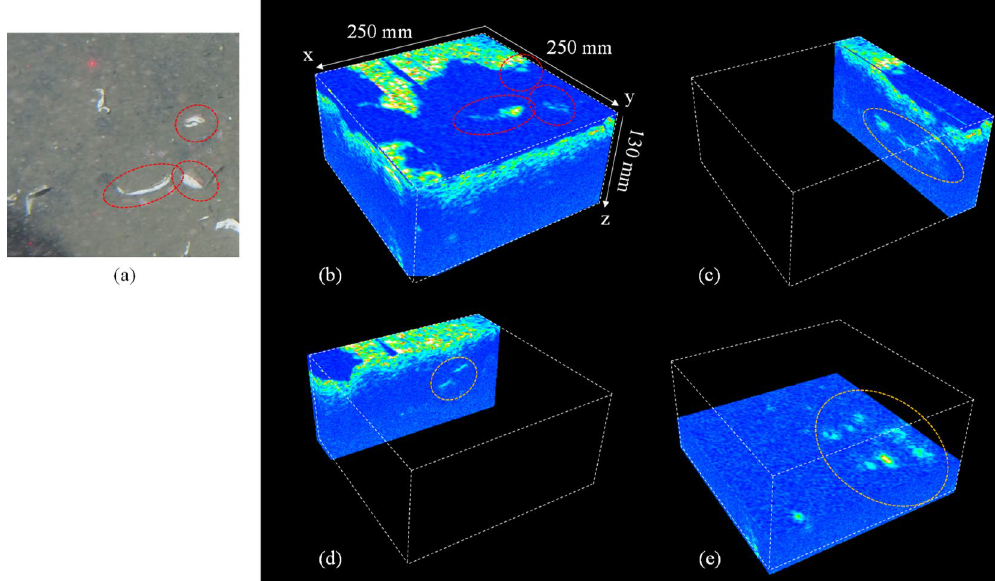
Figure 4. ( a ) Optical image of the seafloor at the observed area. ( b ) 3D acoustic image of the sediment. The position of the top surface is about 95 mm below the surface of the acoustic focus probe. ( c ) The cross-sectional view on the y–z plane at x = 40 mm. ( d ) The cross-sectional view on the x–z plane at y = 50 mm. ( e ) The cross- sectional view on the x–y plane at z = 79 mm. The same exposed empty valves can be seen in both optical ( a ) and acoustic (b) images (red ellipse dashed line). The strong backscatters can be detected at the cross-sectional views (yellow ellipse dashed line). The distance in z is estimated by the time difference with the sound speed of 1500 m/s as a